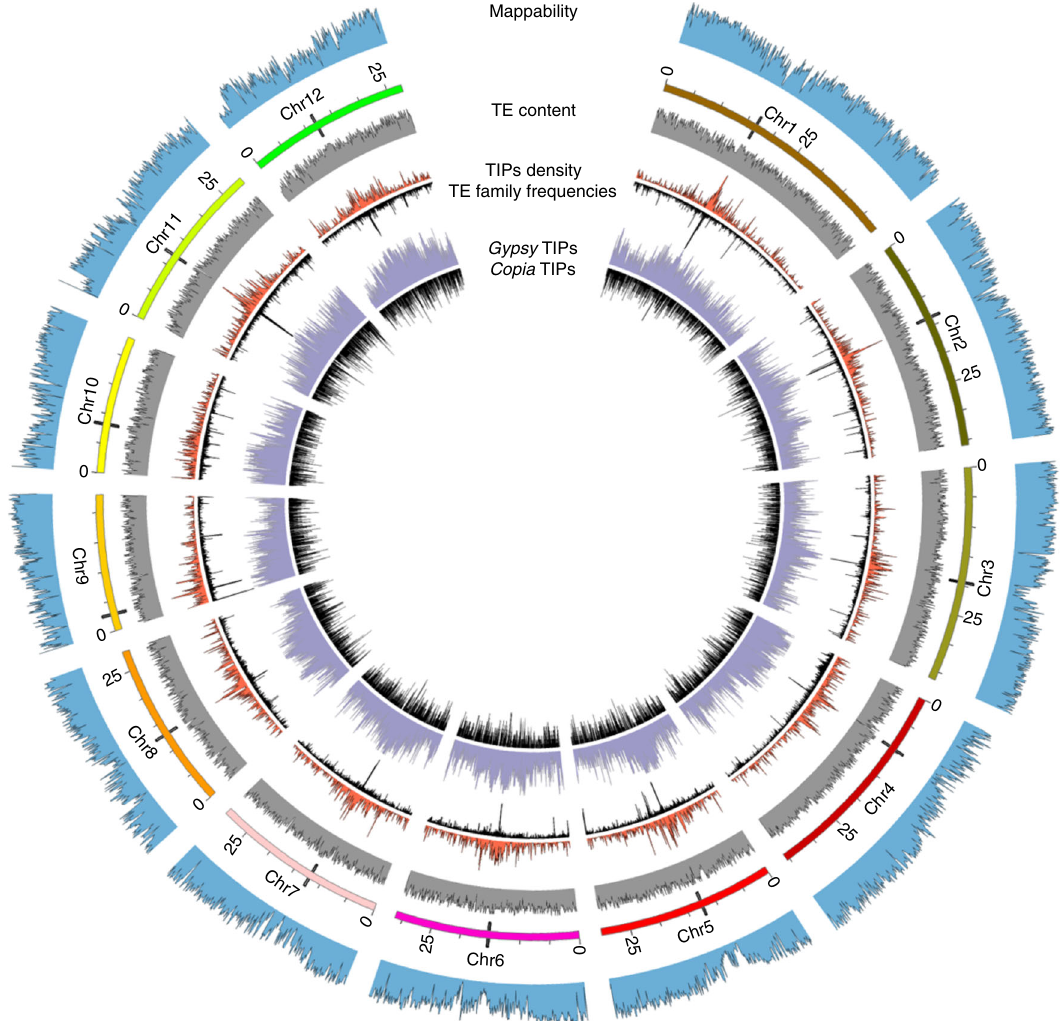
Fig. 3 Circos representation. From outside to inside: the fi rst circle corresponds to the mappability of the 12 rice chromosomes (see Methods). The second circle represents the 12 chromosomes of rice genome. For each chromosome, the black tips correspond to the centromere. The third circle represents the TE content: all TE insertions present in rice annotation fi le. The fourth circle (in red) corresponds to the mapping of the TIPs for all the 32 TE families and opposed, below, in black, the fi fth circle shows the number of different TE families for each TE insertion polymorphisms (TIPs), (i.e., the scale is from 1 to 32). The sixth circle represents the distribution of TE insertions per LTR-retrotransposon type: Gypsy (purple) or Copia